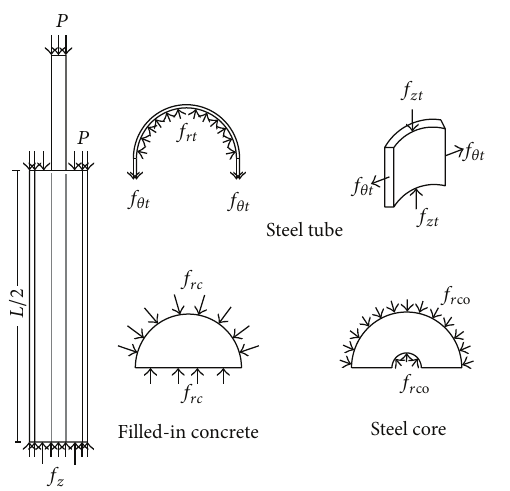
Figure 12: Equilibrium relationship between BRB components.